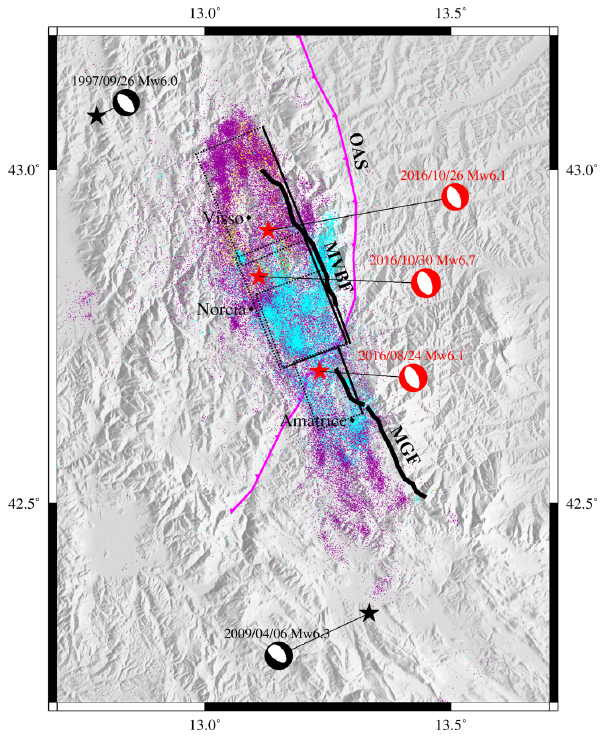
Figure 5. Seismotectonic setting of the Central Italy earthquake se- quence. The three major earthquakes in the sequence are denoted by the red stars and beach ball symbols, and the two recent large histor- ical events are colored in black. The dashed black rectangles repre- sent the surface projection of the fault planes adopted in this study. The bold black lines are the two seismogenic normal fault systems, namely, the Mt. Vettore–Mt. Bove Fault system (VBFS) and the Mt. Gorzano Fault system (GFS). The pink line shows the simplified trace of the preexisting compressional front named the Olevano– Antrodoco–Sibillini (OAS) Thrust. Aftershocks are marked by the small dots with different colors. The blue, purple, and yellow points represent the events taking place on 24 August–24 October 2016, 24–30 October 2016, and 30 October 2016–8 October 2017, respec-